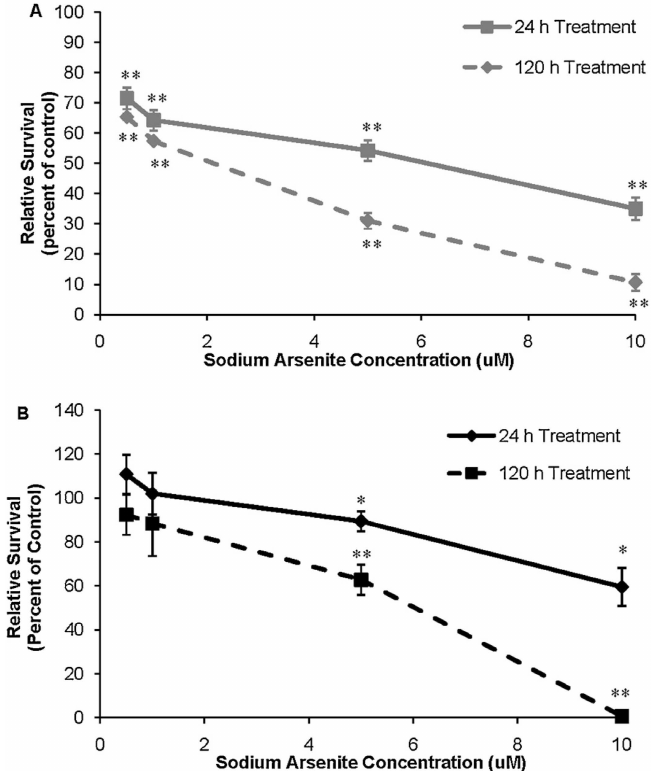
Figure 6. Cytotoxicity of sodium arsenite in: ( A ) human lung fibroblast cells, and ( B ) human lung epithelial cells, following 24 and 12 h treatments. Reprinted from Xie et al. [189] with permission from